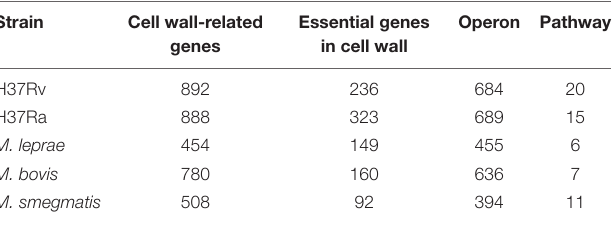
TABLE 1 | Cell wall synthesis network module in mycobacteria. Strain Cell wall-related